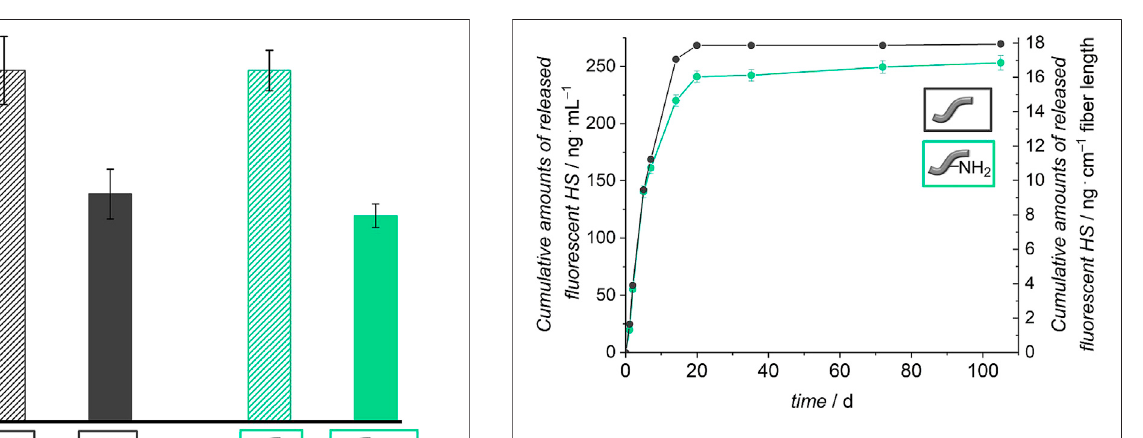
FIGURE 7 | Release of HS from unmodi fi ed and amino-modi fi ed (PBS with 0.1% BSA, 110 days, 37 ° C). The left axis represents the cumulative HS release referred to 1 ml release medium and the right axis shows the cumulative release of HS with regard to 1 cm fi ber